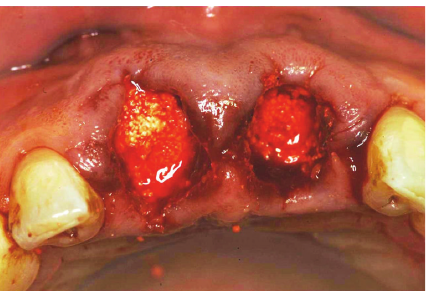
Figure 2: Filling of granules of bone substitute (Bio-Oss spongiosa) into the socket.